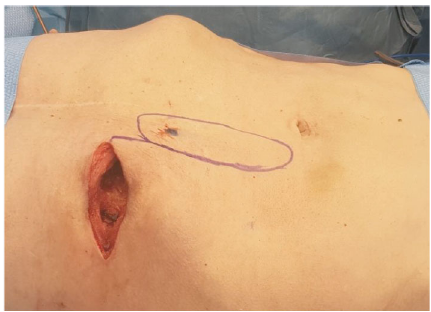
Figure 4: Intraoperative picture at time of reconstruction after 4 cycles of VAC Therapy. The defect at the level of the 7 th rib measured 10 × 6 × 4 cm. The superior epigastric artery perforator (SEAP) fl ap was designed with the musculocutaneous perforator reaching the skin at the proximal end of the fl ap (black